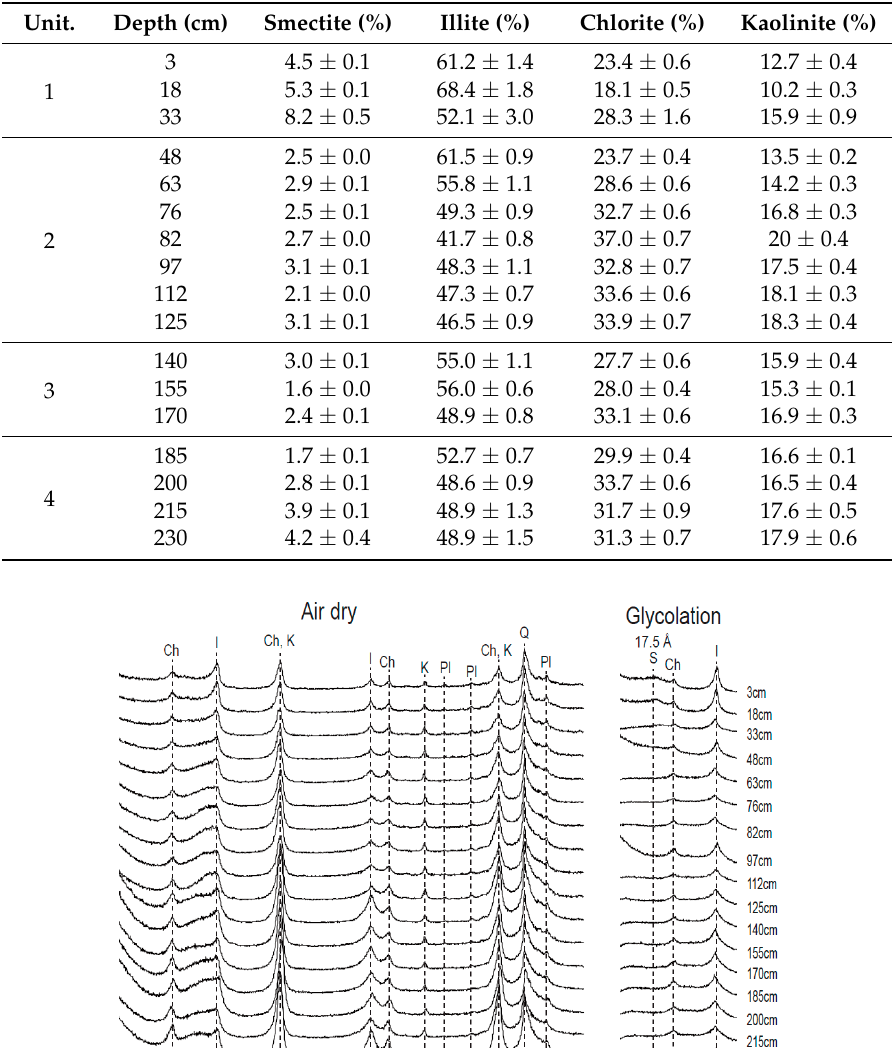
Table 1. Relative abundance of clay minerals in the EAP13-GC17 core. Unit.